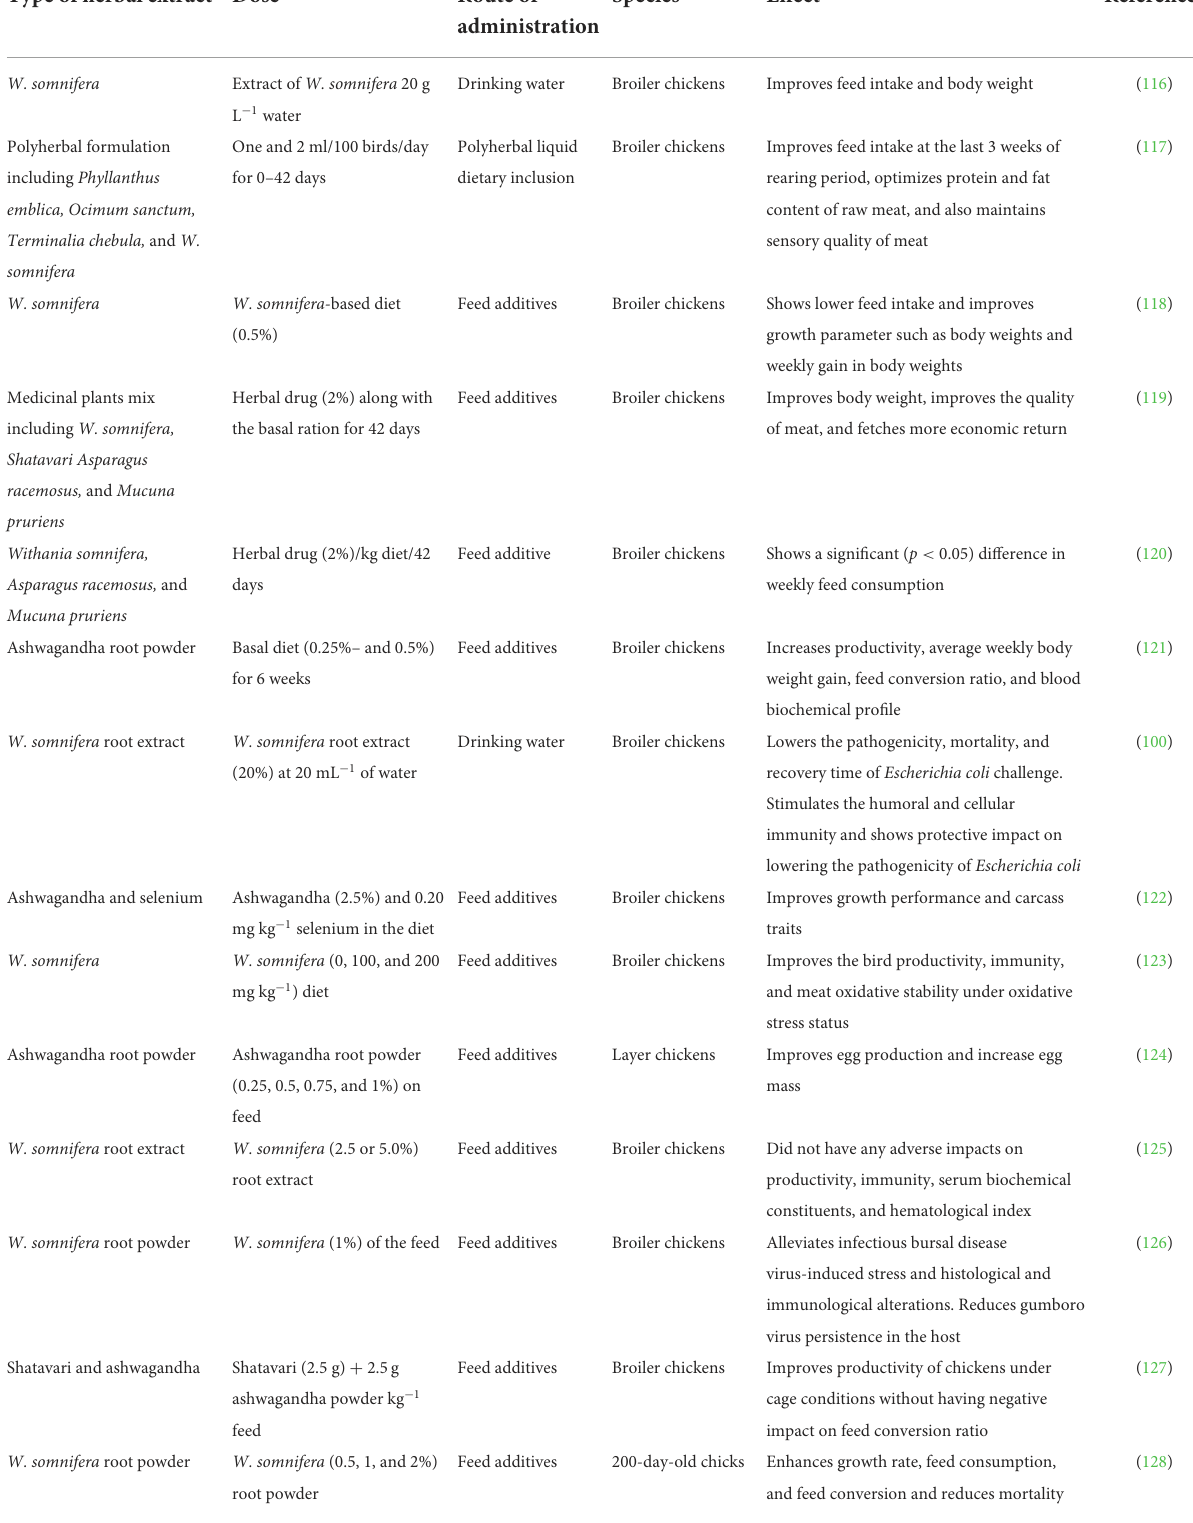
TABLE 1 Withania somnifera effects and